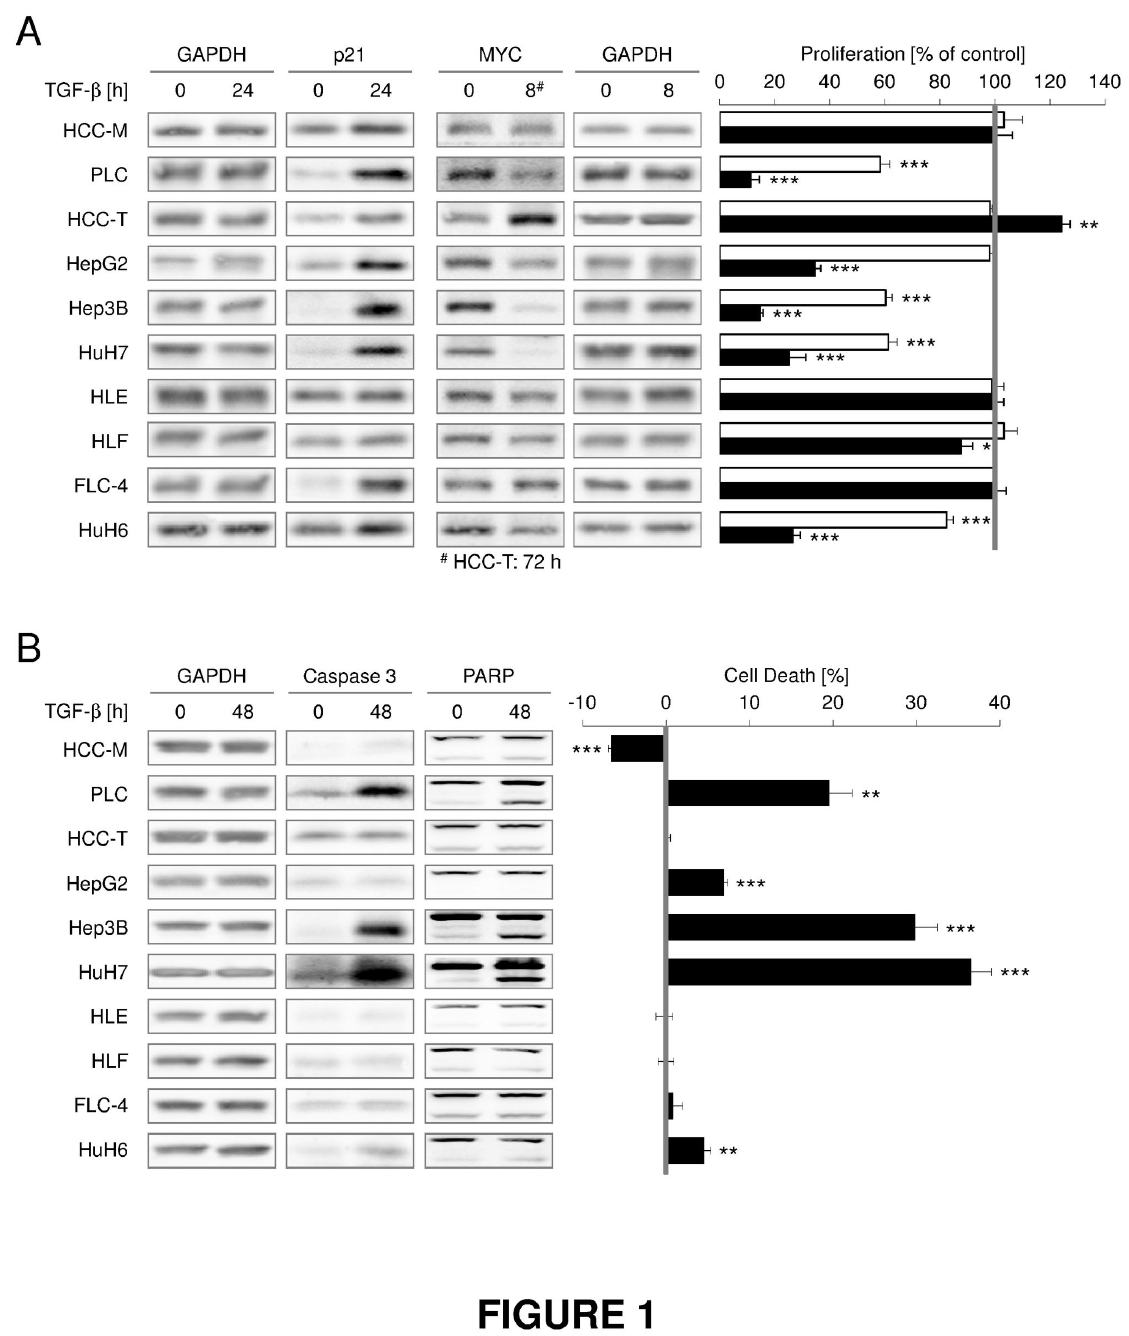
Figure 1. TGF-β induces cell death and/or inhibits proliferation in PLC, HepG2, HuH6, Hep3B and HuH7. (A) Left side: HCC cell lines were treated with 5 ng/ml TGF-β for indicated time points. Changes in c-MYC and P21 expression were detected using Western blot analysis with GAPDH as loading control. As HCC-T cells show a delayed TGF-β response, c-MMYC was induced after 72 h of TGF-β treatment. Right side: After TGF-β treatment for 0 (grey line), 2 (white bars) or 6 days (black bars) cell proliferation was evaluated by MTT assays. Treated samples were normalized to the corresponding control. (B) Left side: Western blot analysis of PARP and Caspase 3 cleavage using GAPDH expression as loading control after 0 and 48 h TGF-β treatment. In the case of HuH7 cells, the control sample was treated with TGF-β for 3 h. Right side: Cell death induced by 5 ng/ml TGF-β over 72 h (filled bars) was quantified by detecting LDH release normalized to total amount of LDH. Untreated samples were defined as 0 (grey line). Significant differences are indicated as * p < 0.05, ** p < 0.01 and *** p < 0.001 (Student’s t test). doi: 10.1371/journal.pone.0072252.g001 PLOS ONE |